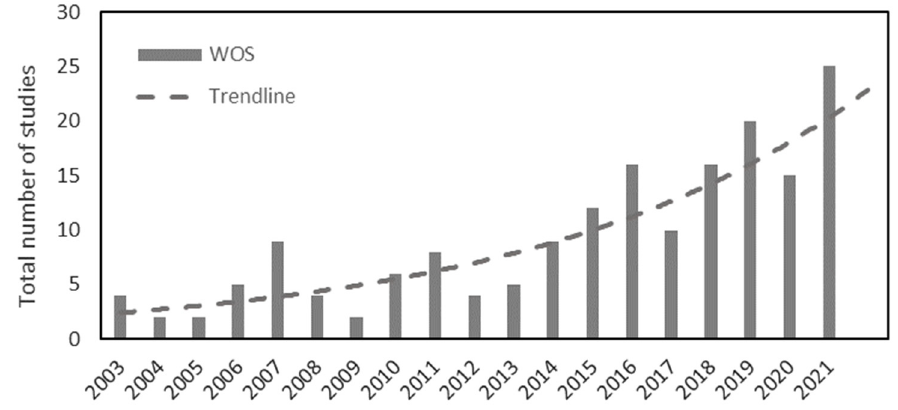
Figure 1. Number of rice and wheat N retrieval research studies per year from 2003 to 2021.